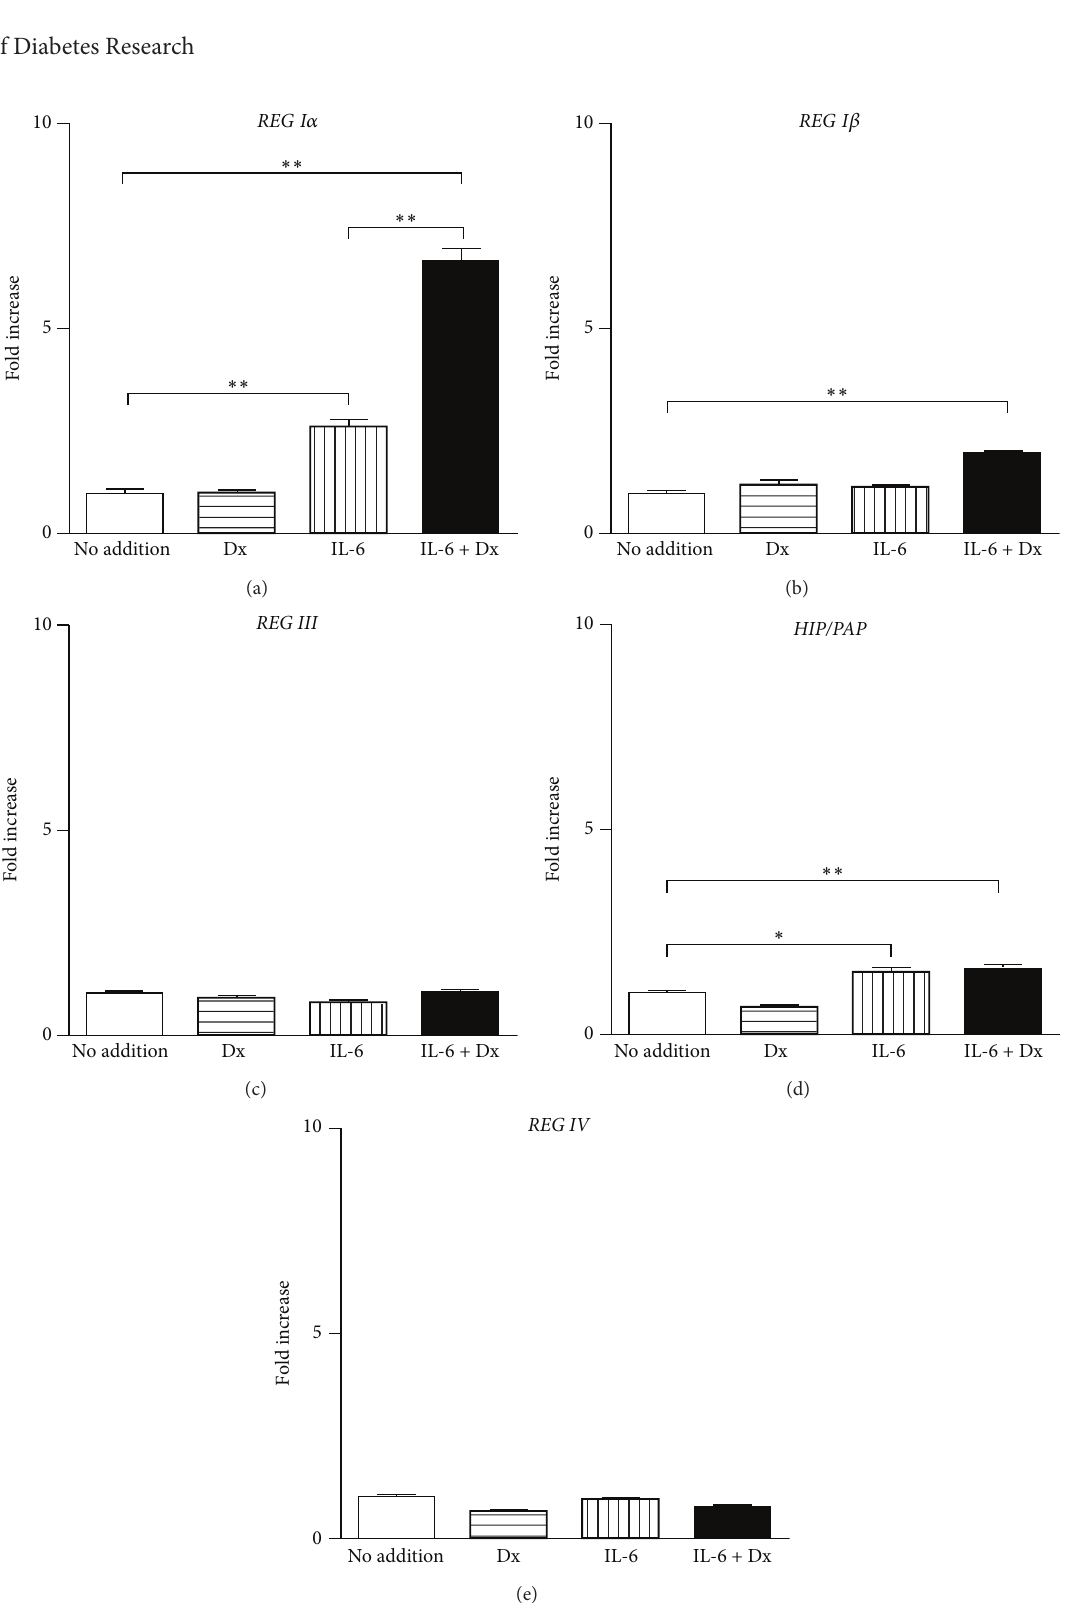
Figure 2: Effects of Dx and IL-6 on the promoter activity of (a) REG I 𝛼 , (b) REG I 𝛽 , (c) REG III , (d) HIP/PAP , and (e) REG IV in rat RINm5F cells. RINm5F cells were transfected with the human REG family gene reporter plasmids and treated without (no addition) or with Dx (100nM), or IL-6 (20ng/mL), or IL-6 + Dx. The promoter activity was normalized for variations in transfection efficiency using 𝛽 -galactosidase activity as an internal standard. Fold increase is calculated by dividing the promoter activity of stimulated cells by that of unstimulated cells (No addition). Data are expressed as means ± SE for each group ( 𝑁 = 3 ). ∗ 𝑃 < 0.01 ; ∗∗ 𝑃 < 0.005